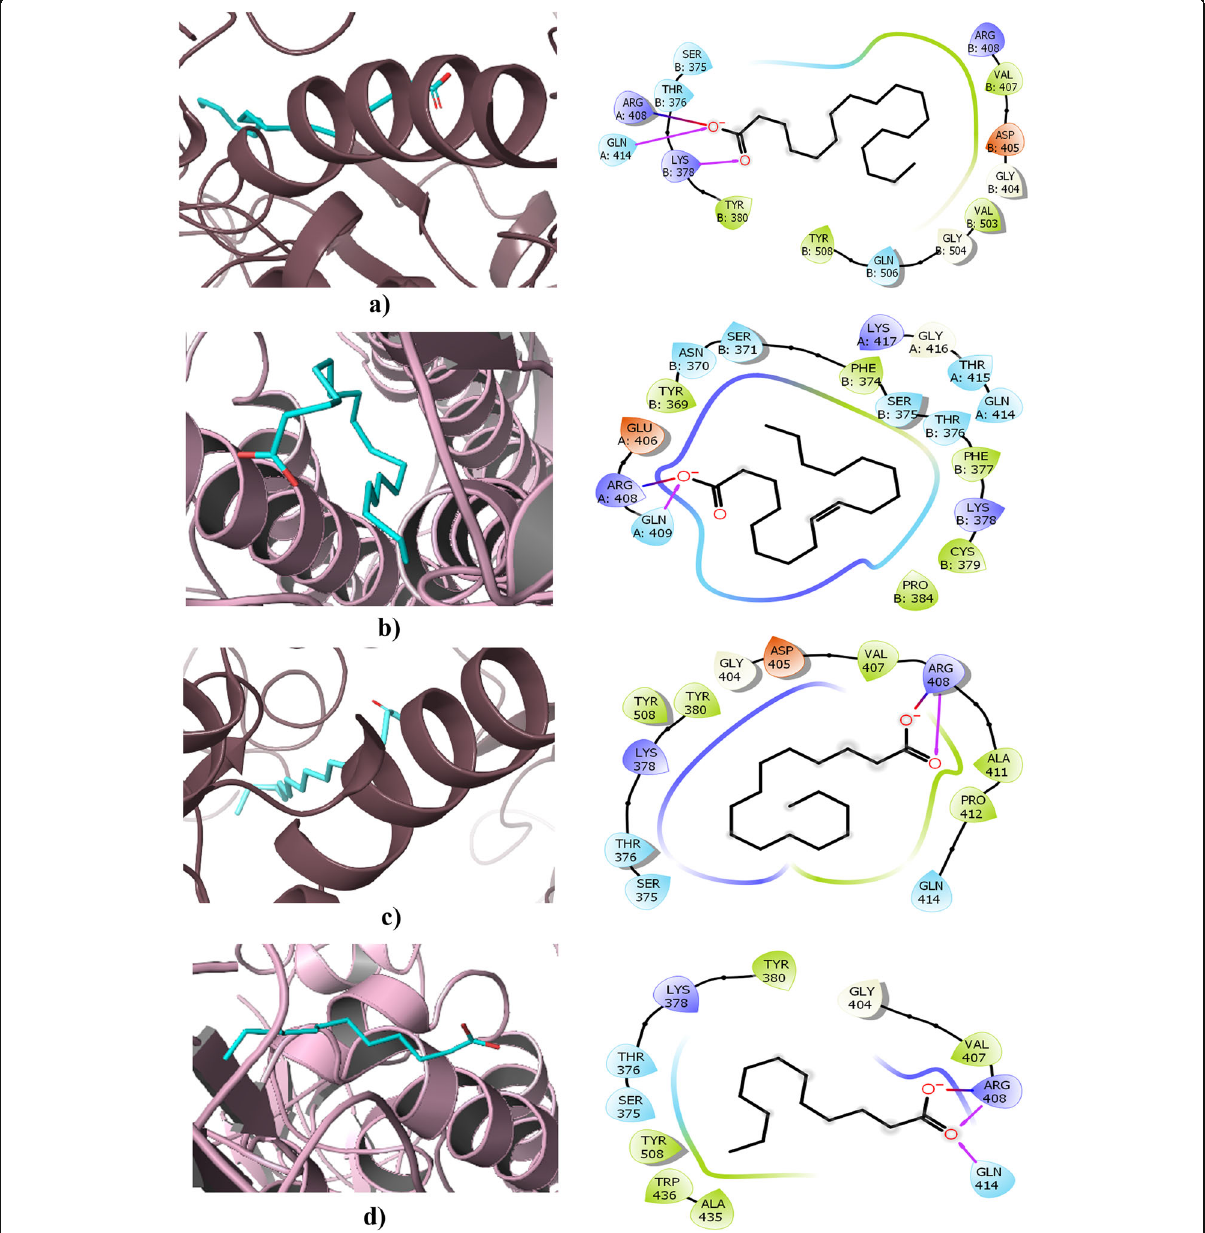
Fig. 6 Free fatty acids bound at the binding pocket in the RBD domain of spike proteins a stearic acid; b oleic acid; c palmitic acid; d lauric